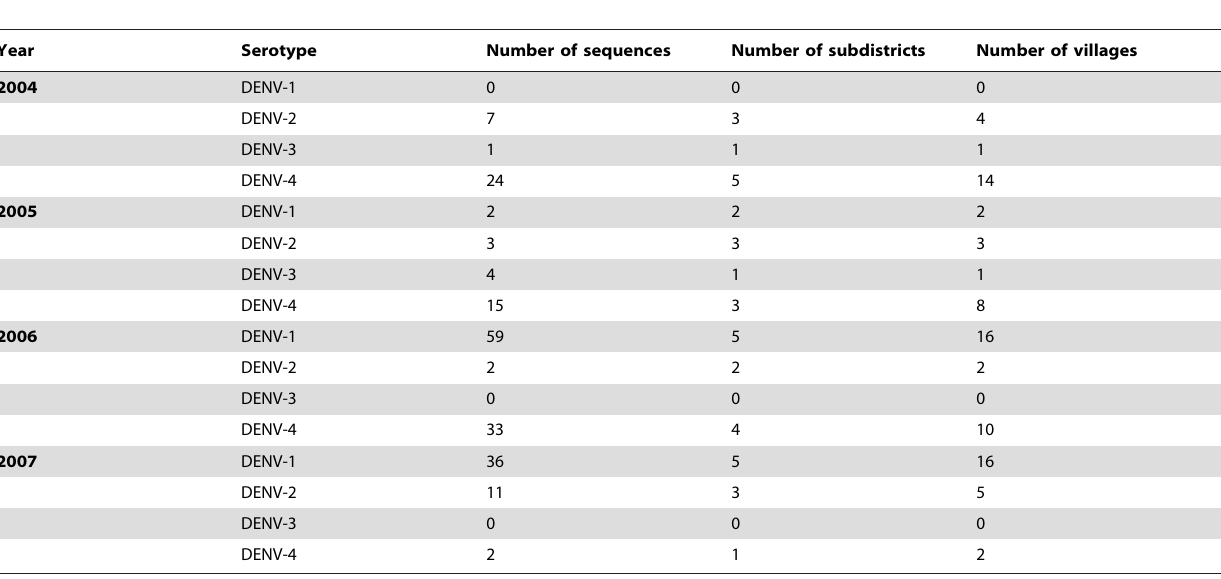
Table 1. DENV sequences from school children and community clusters in five sub-districts of KPP,